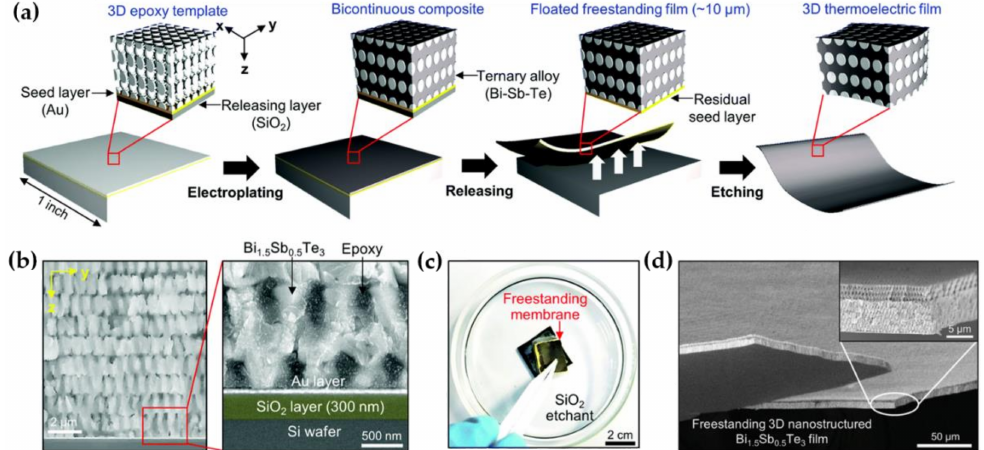
Figure 6. Fabrication process of a freestanding membrane: ( a ) Schematic illustration of fabricating a freestanding membrane; ( b ) SEM image of cross-sectional view of 3D nanostructured Bi-Sb-Te showing SiO 2 layer as a sacrificial layer; ( c ) Digital image of a delaminated 3D sample from the Si substrate after wet etching process and ( d ) SEM image of a freestanding 3D nanostructured Bi-Sb-Te after dry etching process (reprinted with permission from [38]. Copyright 2017 The Royal Society of